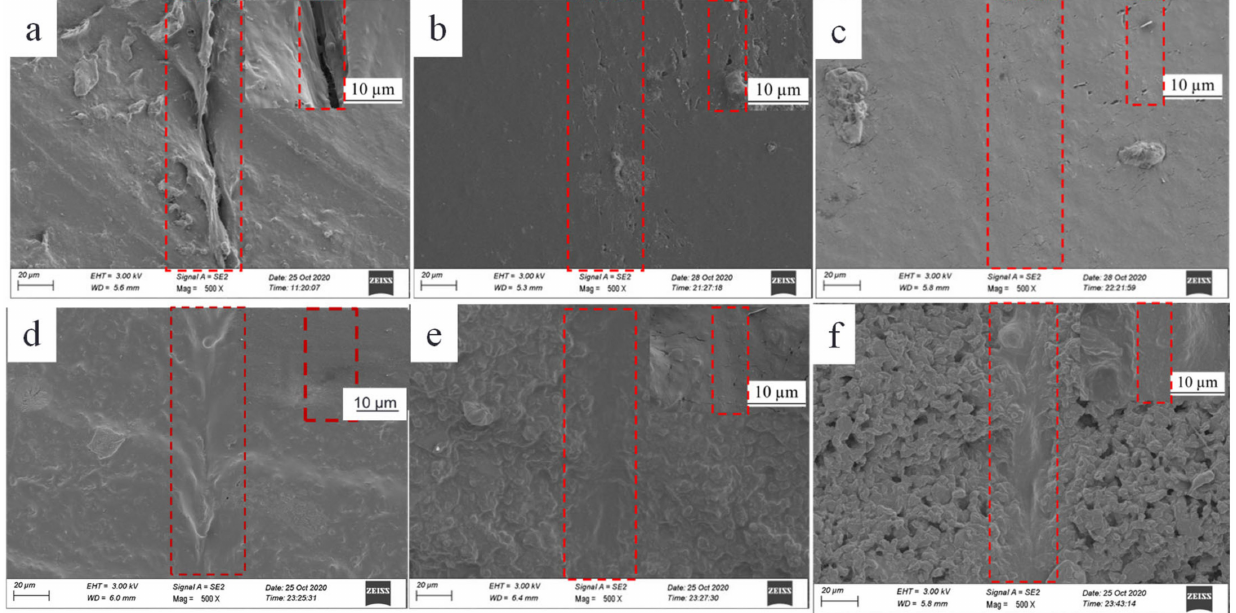
Figure 10. SEM images of the self-healing of the pure TPU ( a ) and the composite films prepared with 20 wt% of TPU and graphene loadings of 0.6 wt% ( b ), 2 wt% ( c ),3 wt% ( d ), 4 wt% ( e ) and 5 wt% ( f ), under IR irradiation for 10 min,